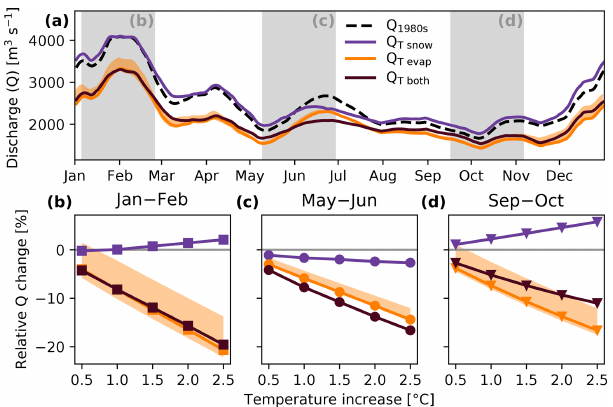
Figure 5. Discharge sensitivity to temperature increase. Panel (a) shows the yearly average discharge under a 2.5 ◦ C increase, and panel (b) shows changes during typical discharge events with step- wise temperature increases. Typical discharge periods highlighted in (a) match the periods used to compare the mean discharges in (b, c, d) . Shaded orange areas indicate the uncertainty induced by ef- fective rooting depth (25–125mm), where higher discharges match shallower depths and vice